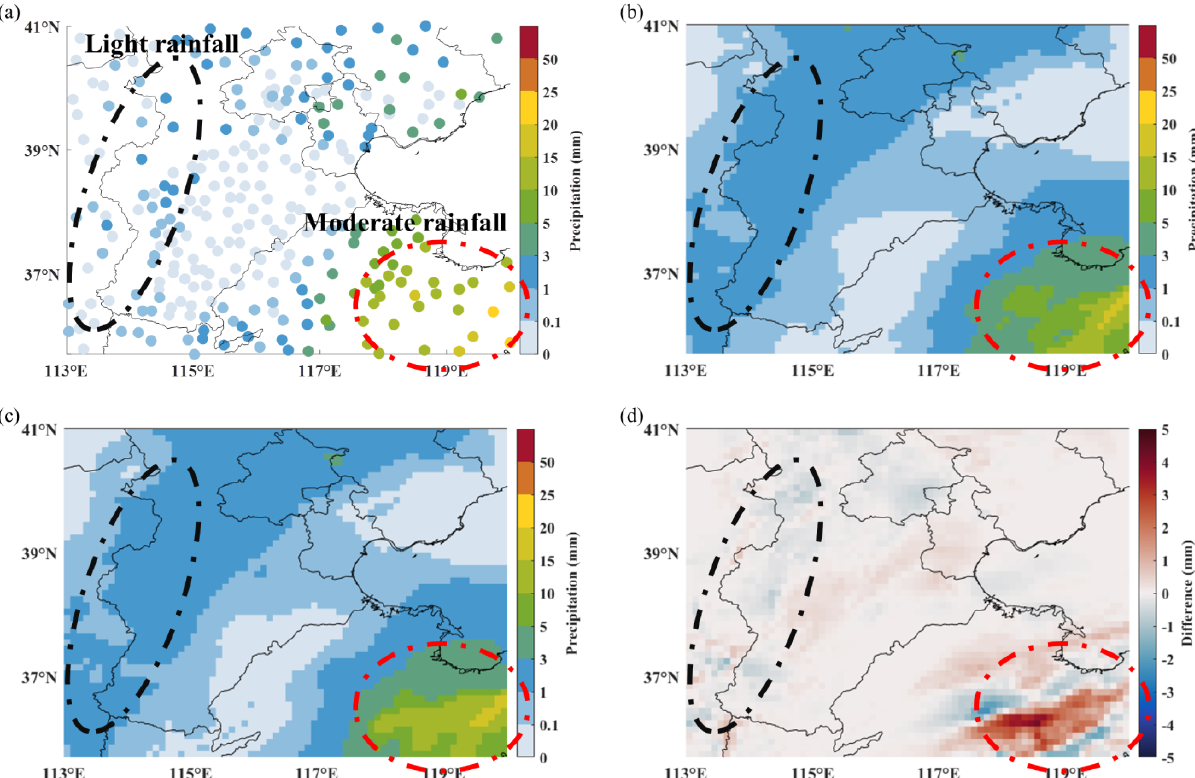
Figure 9. The spatial distribution of 24h cumulative precipitation on 7 January 2017. (a) The observations. (b) The E1 experiment. (c) The E2 experiment. (d) The difference between the E2 and E1 experiment. The red and black ovals represent the moderate- and light-rainfall areas, respectively.